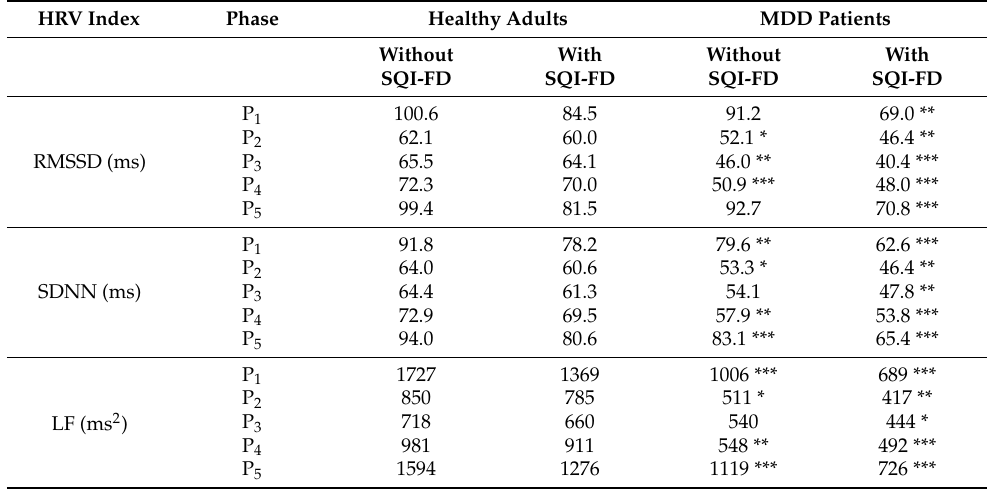
Table 4. Differences in HRV indices with and without thresholding by real-time calculation of signal quality indices in the frequency domain